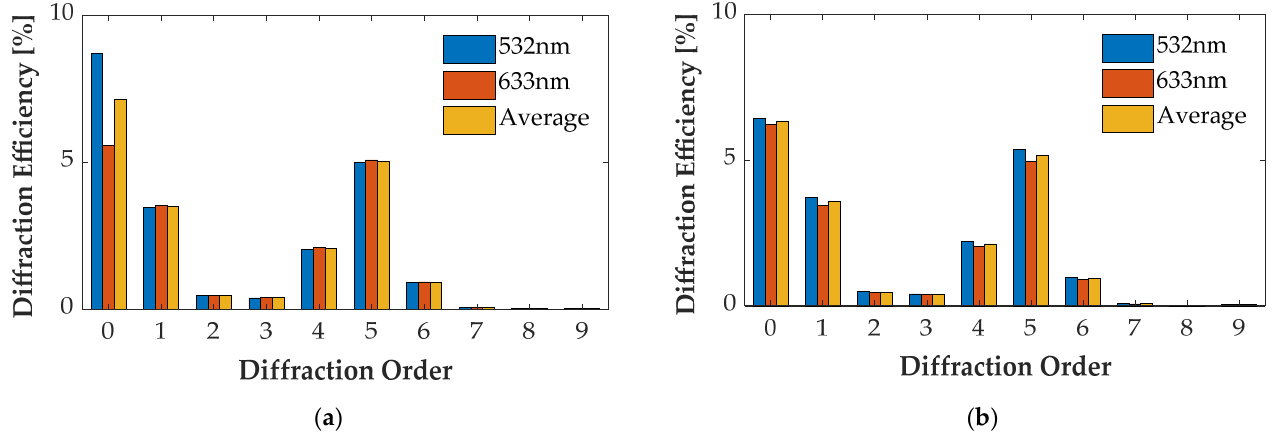
Figure 21. Diffraction efficiency of AH53. ( a ) AH53 with the groove depth of 158.25 nm; ( b ) AH53 with the groove depth of 143 nm.